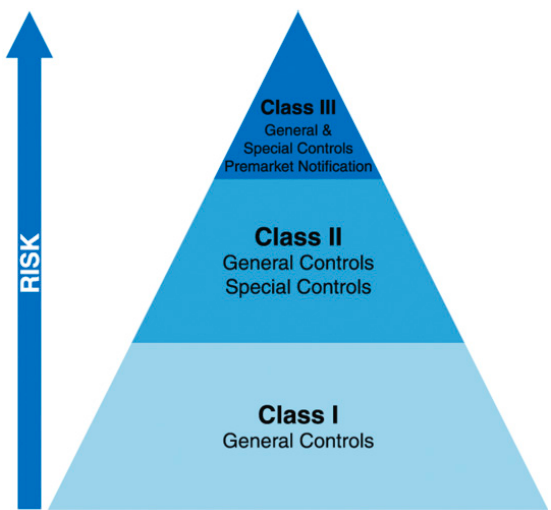
Figure 13. Categorization of medical equipment depending on the degree of risk to the patient.